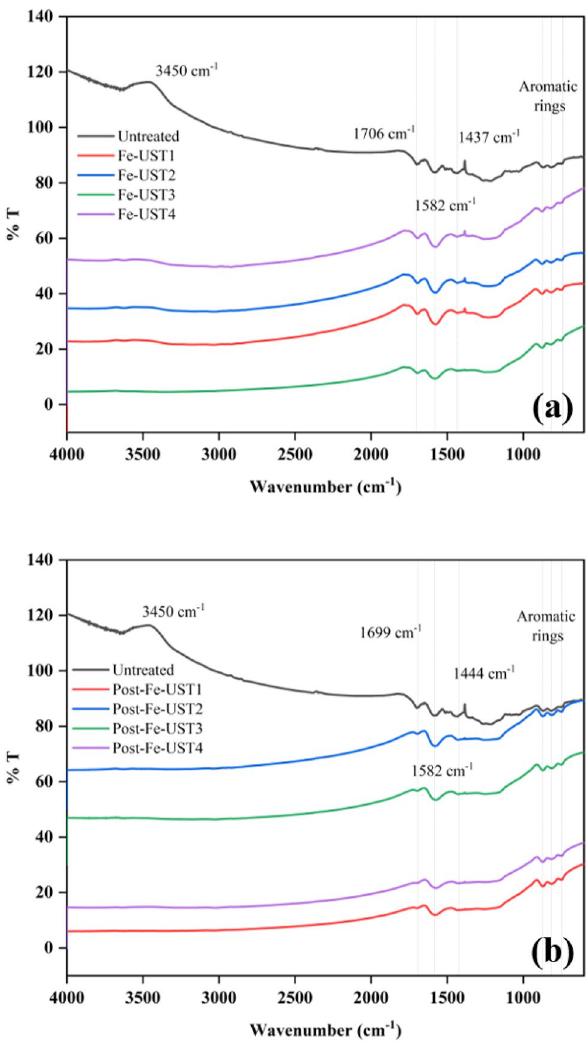
Fig. 5 Infrared spectra of Fe-impregnated biochars prepared from a pre-pyrolysis methods b post-pyrolysis method